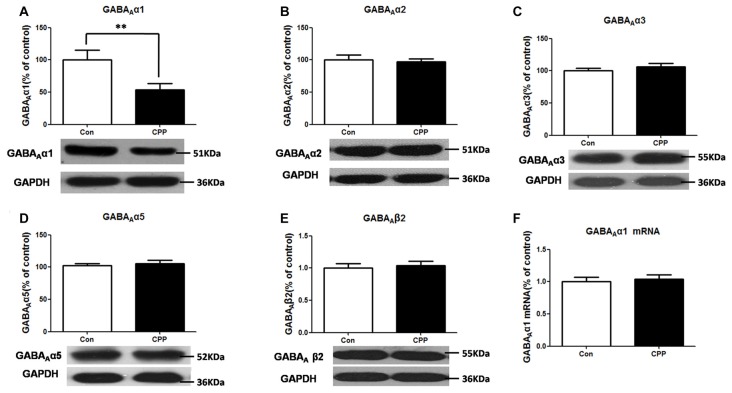
Decrease in GABAAα1 protein expression in the dorsal straitum (Dstr) of methamphetamine-conditioned place preference (METH-CPP) rat. (A) Dstr GABAAα1 protein expression level decreased in METH-CPP rat. (B–E) There were no changes of the expression levels of GABAAα2 (B), GABAAα3 (C), GABAAα5 (D) and GABAAβ2 (E) after METH pairing. (F) mRNA was determined by qRT-PCR, and the values were normalized to the geometric mean of a control gene (Glyceraldehyde-3-Phosphate Dehydrogenase (GAPDH). Error bars represent mean ± SEM, n = 5–8 in each group. **p < 0.01 compared with control group, two tailed Student’s t-test.